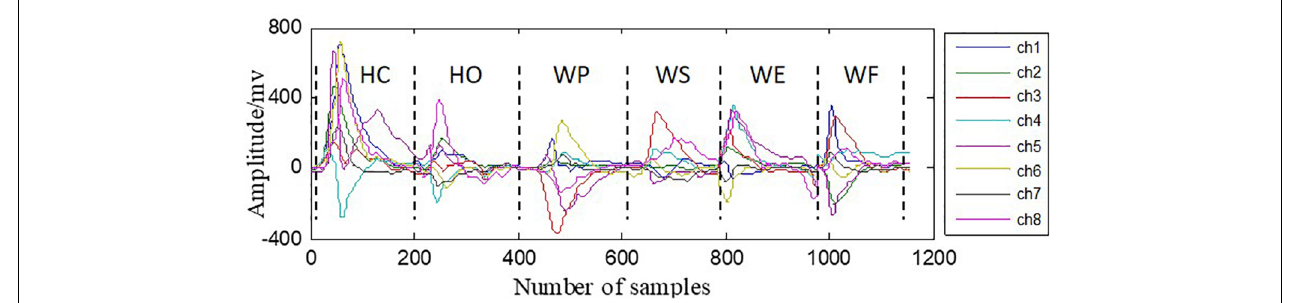
FIGURE 4 | An example of the RSC signals of the eight channels and six hand motions.